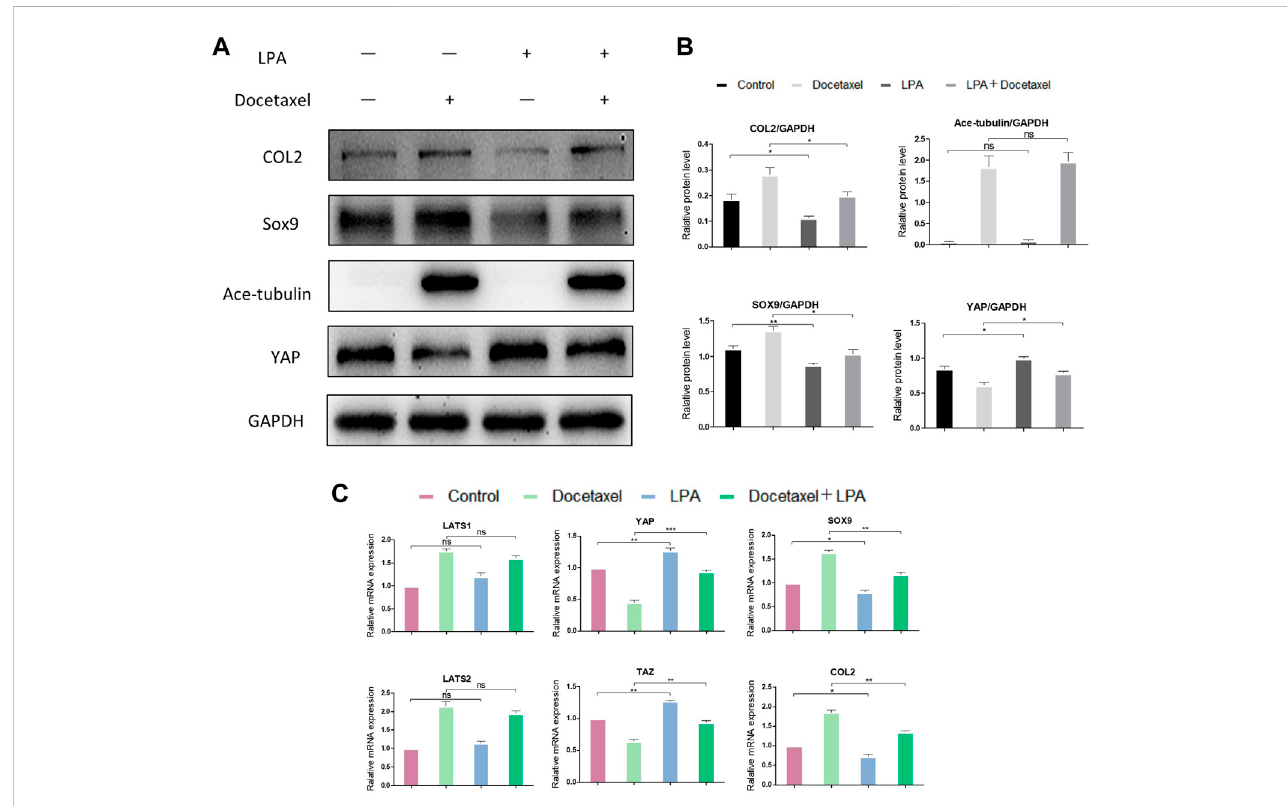
FIGURE 6 The effect of YAP activation on the synthesis of COL2 in NP cells. (A) Western blot analysis of Ace-Tubulin, YAP, COL2 and SOX9 in NP cells treated with lysophosphatidicacid (LPA)and treatedwith docetaxel for1 week. (B) Quanti fi cationofthedataof (A) . n =4. (C) Q-PCRofLATS1,LATS2,TAZ,YAP, COL2 and SOX9 in NP cells treated with LPA and treated with docetaxel for 1 week. Data are represented as the mean ± SEM. * p < 0.05, ** p < 0.01, *** p <